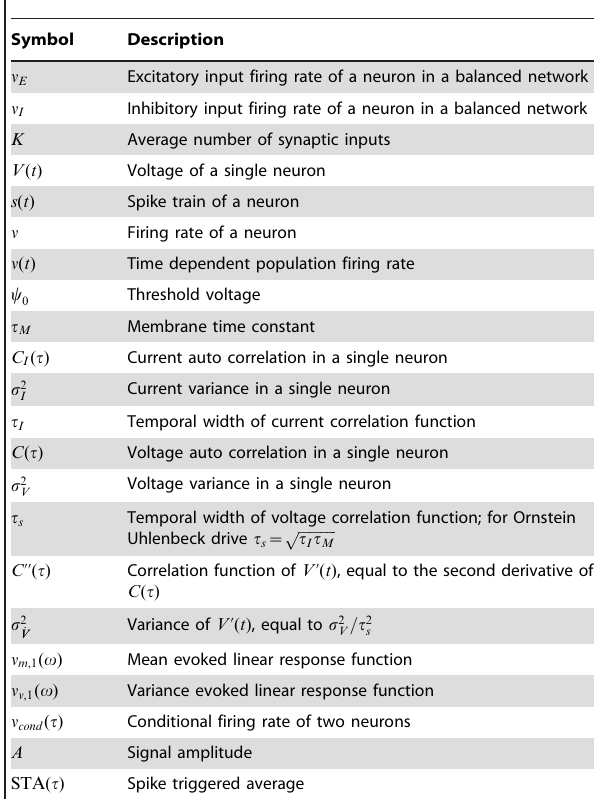
Table 1. Symbol nomenclature in the order of